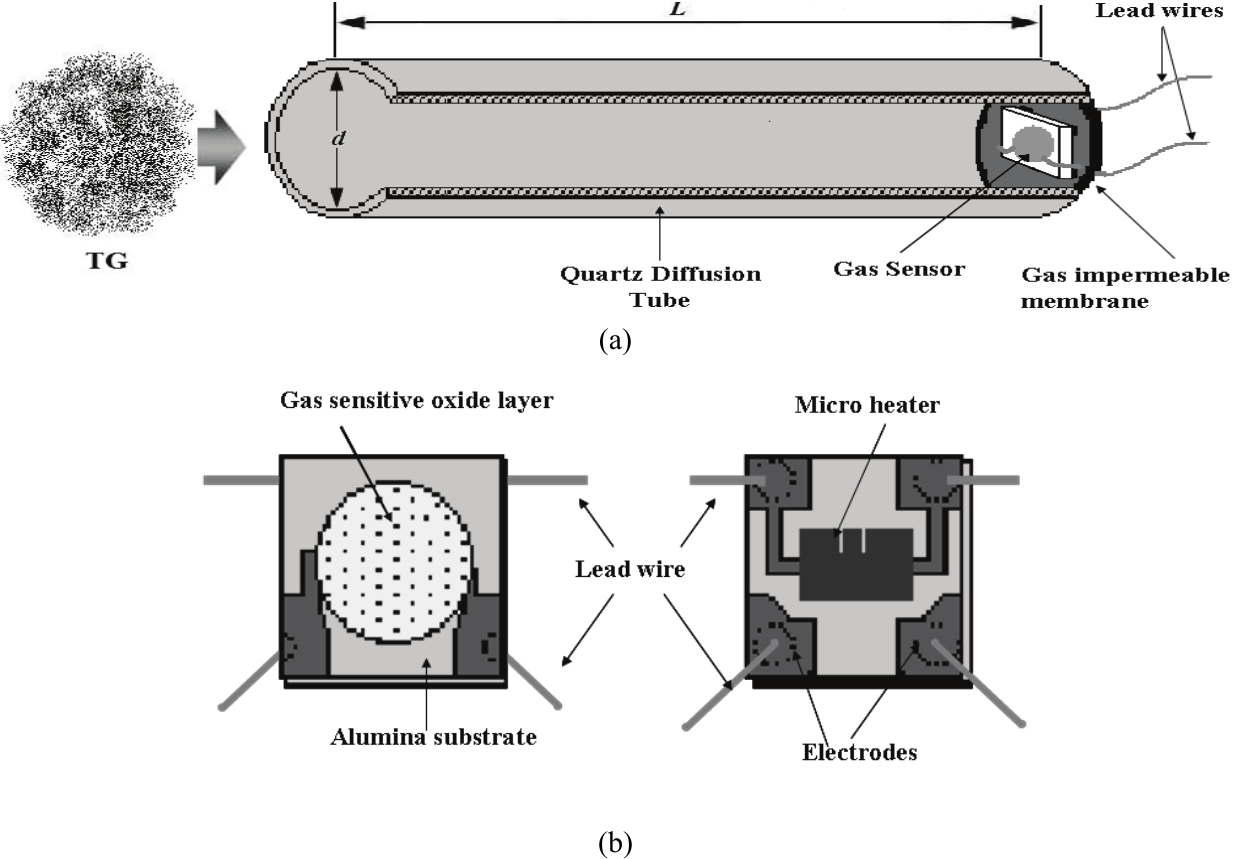
Figure 1. (a) Schematic of the prototype CGS fabricated. (b) Schematic of sensing element of the